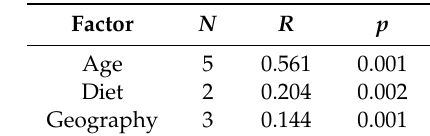
N value indicated the number of groups; R value indicated the correlation; p value indicated significant differences ( p < 0.05).